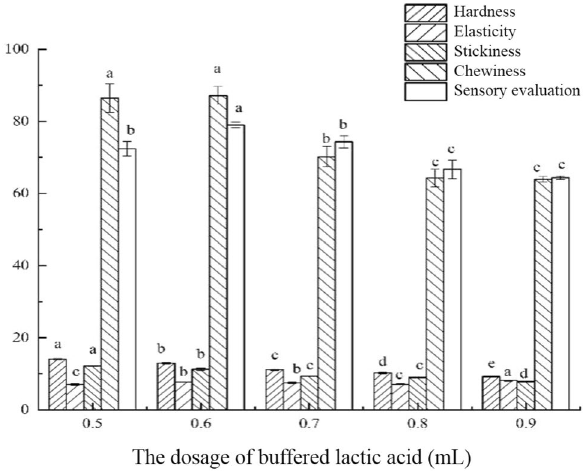
Fig. 4 Effect of the addition of OP solution on the quality of gel